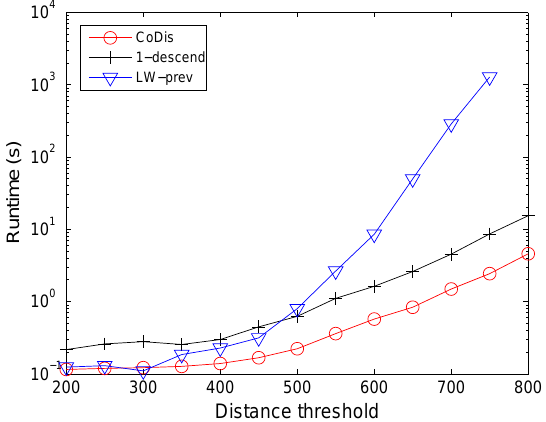
Figure 6. Impact of the distance threshold on the runtime.